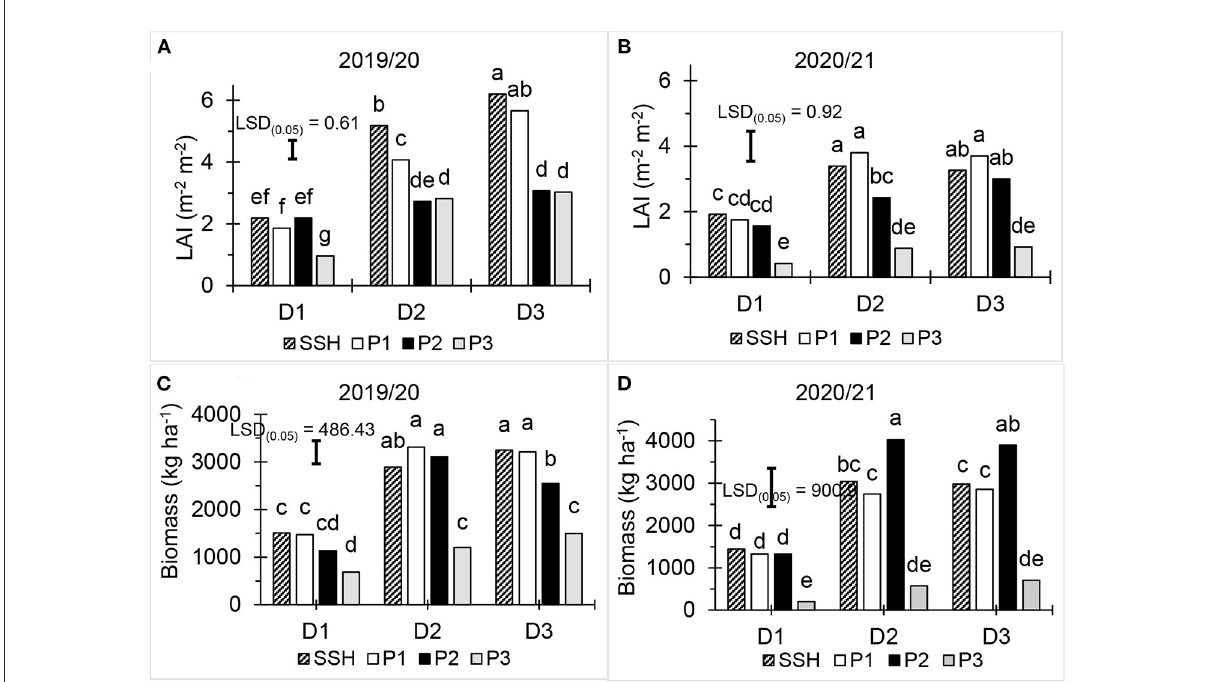
FIGURE4 Planting period and density effects on sunn hemp under the in-field rainwater harvesting technique in the central semiarid area of the Free State Province, South Africa: (A) leaf area index (m − 2 m − 2 ) during 2019/2020 growing season; (B) leaf area index (m − 2 m − 2 ) during 2020/21 growing season; (C) biomass (kg ha − 1 ) during 2019/20 growing season; (D) biomass (kg ha − 1 ) during 2020/21 growing season (SSH, sole sunn hemp; P1, simultaneous sunn hemp and maize planting; P2, sunn hemp planted at the V15 maize growth stage; P3, sunn hemp planted at R1 maize growth stage; D1-low, 16.1 plants m − 2 ; D2-medium, 32.1 plants m − 2 ; D3-high, 48.1 plants m − 2 ). Different letters on the bars indicate statistical significance.